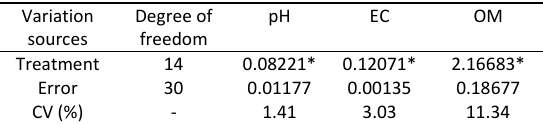
Table 3: ANOVA of soil pH, EC and organic matter under various treatments Table 3. ANOVA of soil pH, EC and organic matter under various treatments Variation sources